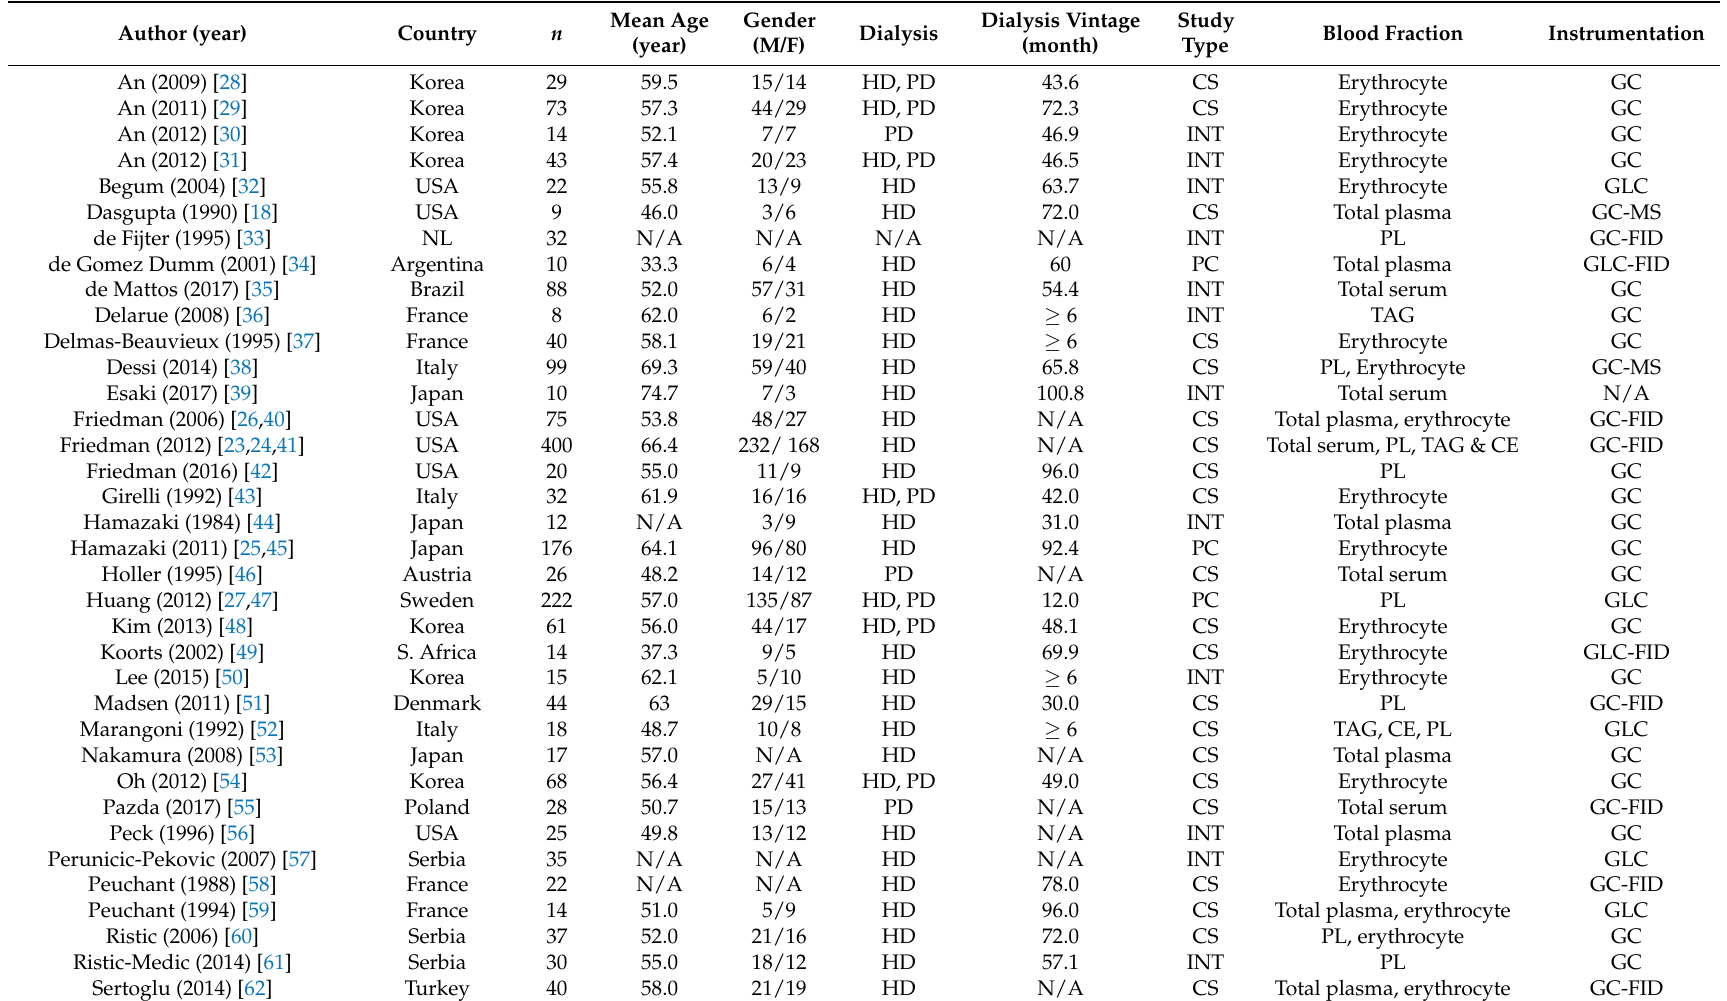
Table 1. Summary of studies included in the